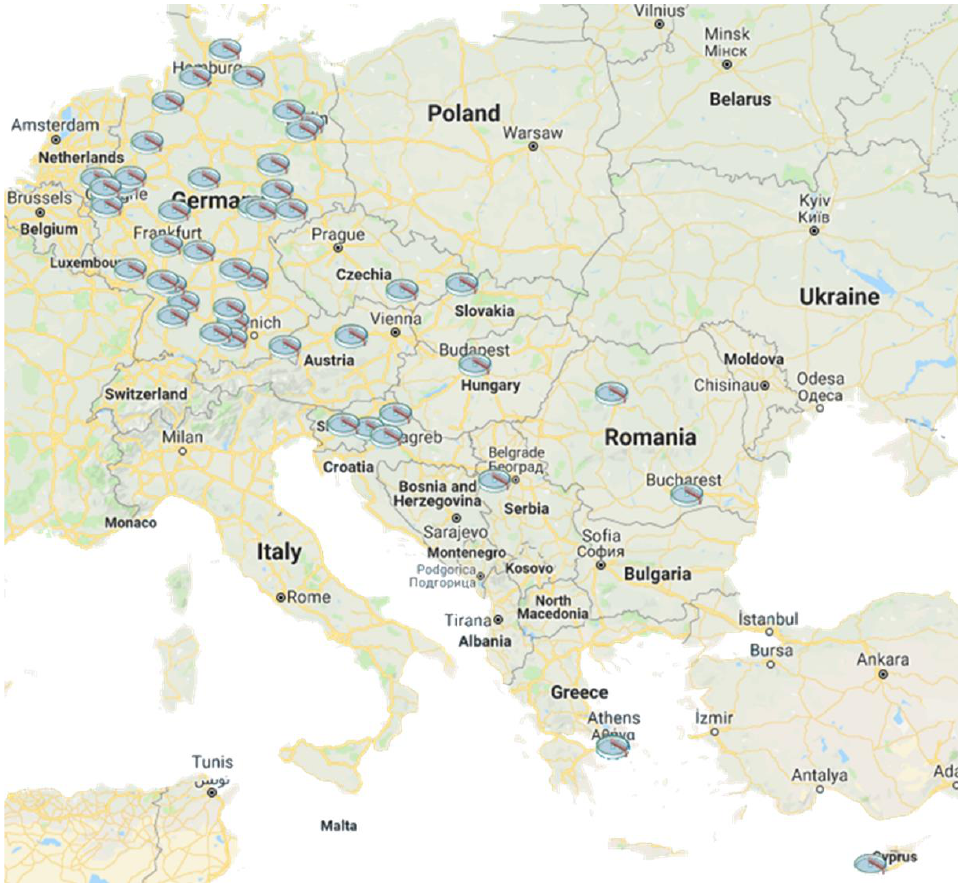
Figure 3. Spatial distribution of the 48 sampled WWTPs. The WWTPs were located in 11 European countries: Germany, Romania, Serbia, Croatia, Slovenia, Hungary, Slovakia, Czechia, Austria, Greece and Cyprus.